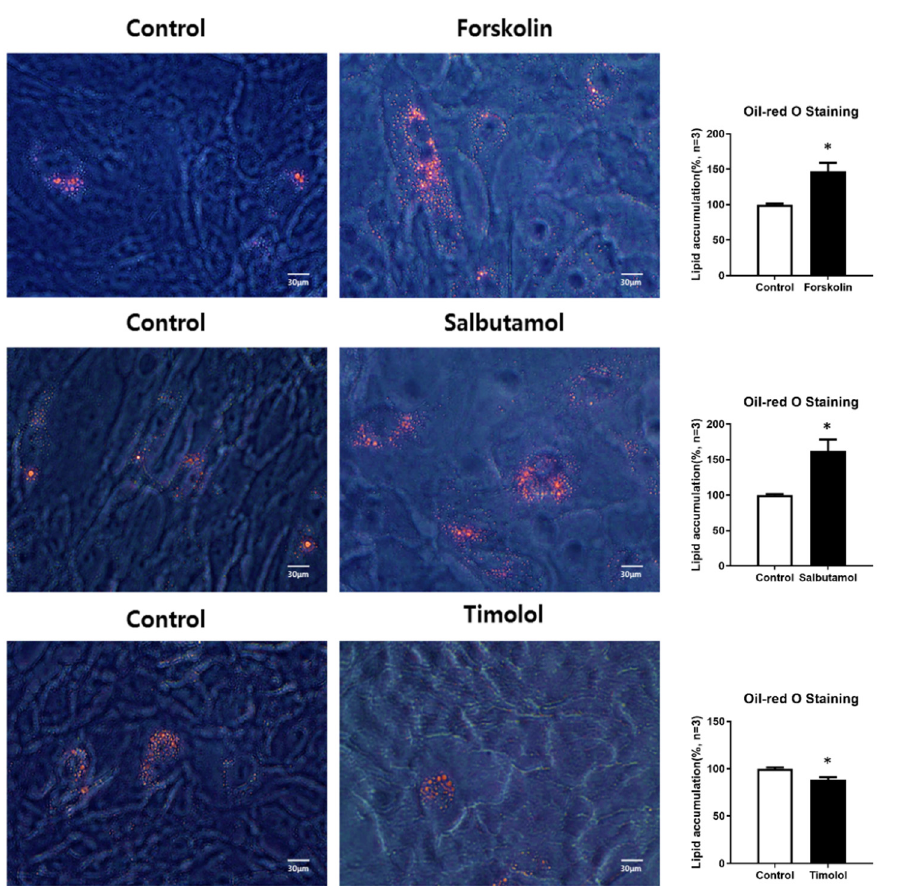
Figure 5. Lipid synthesis was examined by Oil Red O staining at day 4 after treatment with forskolin, salbutamol, and timolol. HMGECs were cultured with or without forskolin, salbutamol, and timolol, and lipid accumulation was assessed using Oil Red O staining on day 4. The results of three experiments are summarized in the right panels. Data are presented as the mean ± standard error of the mean; * p < 0.05.